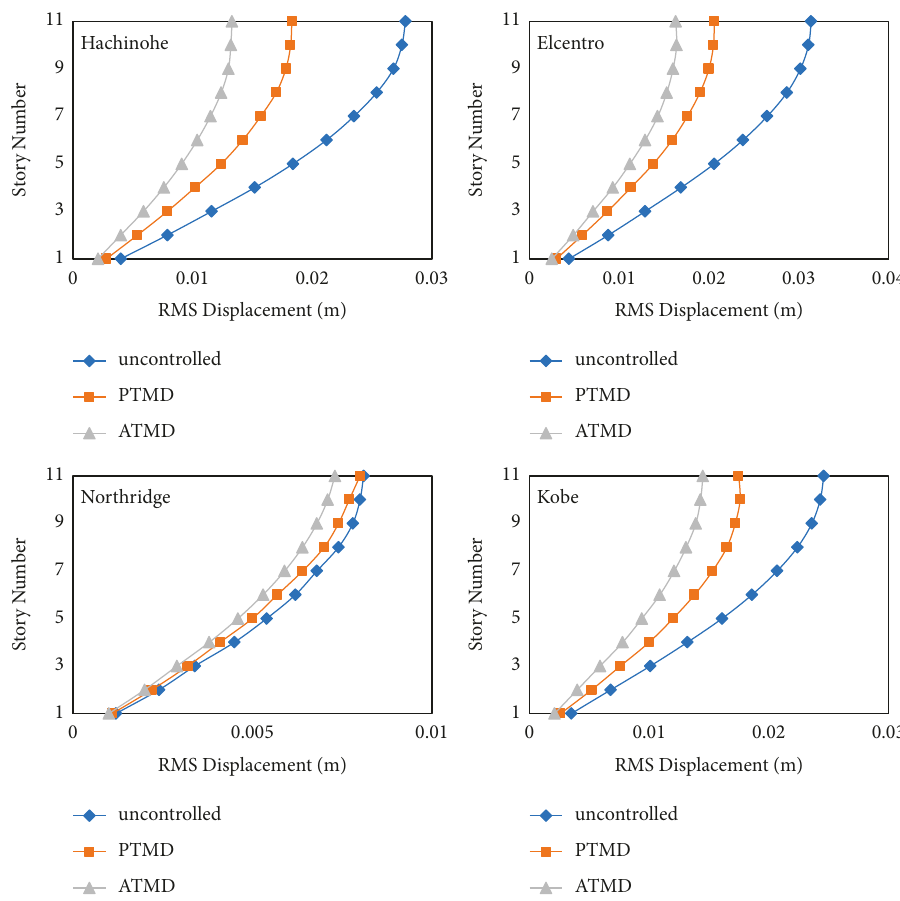
Figure 7: RMS displacement of structural floors with PTMD and ATMD